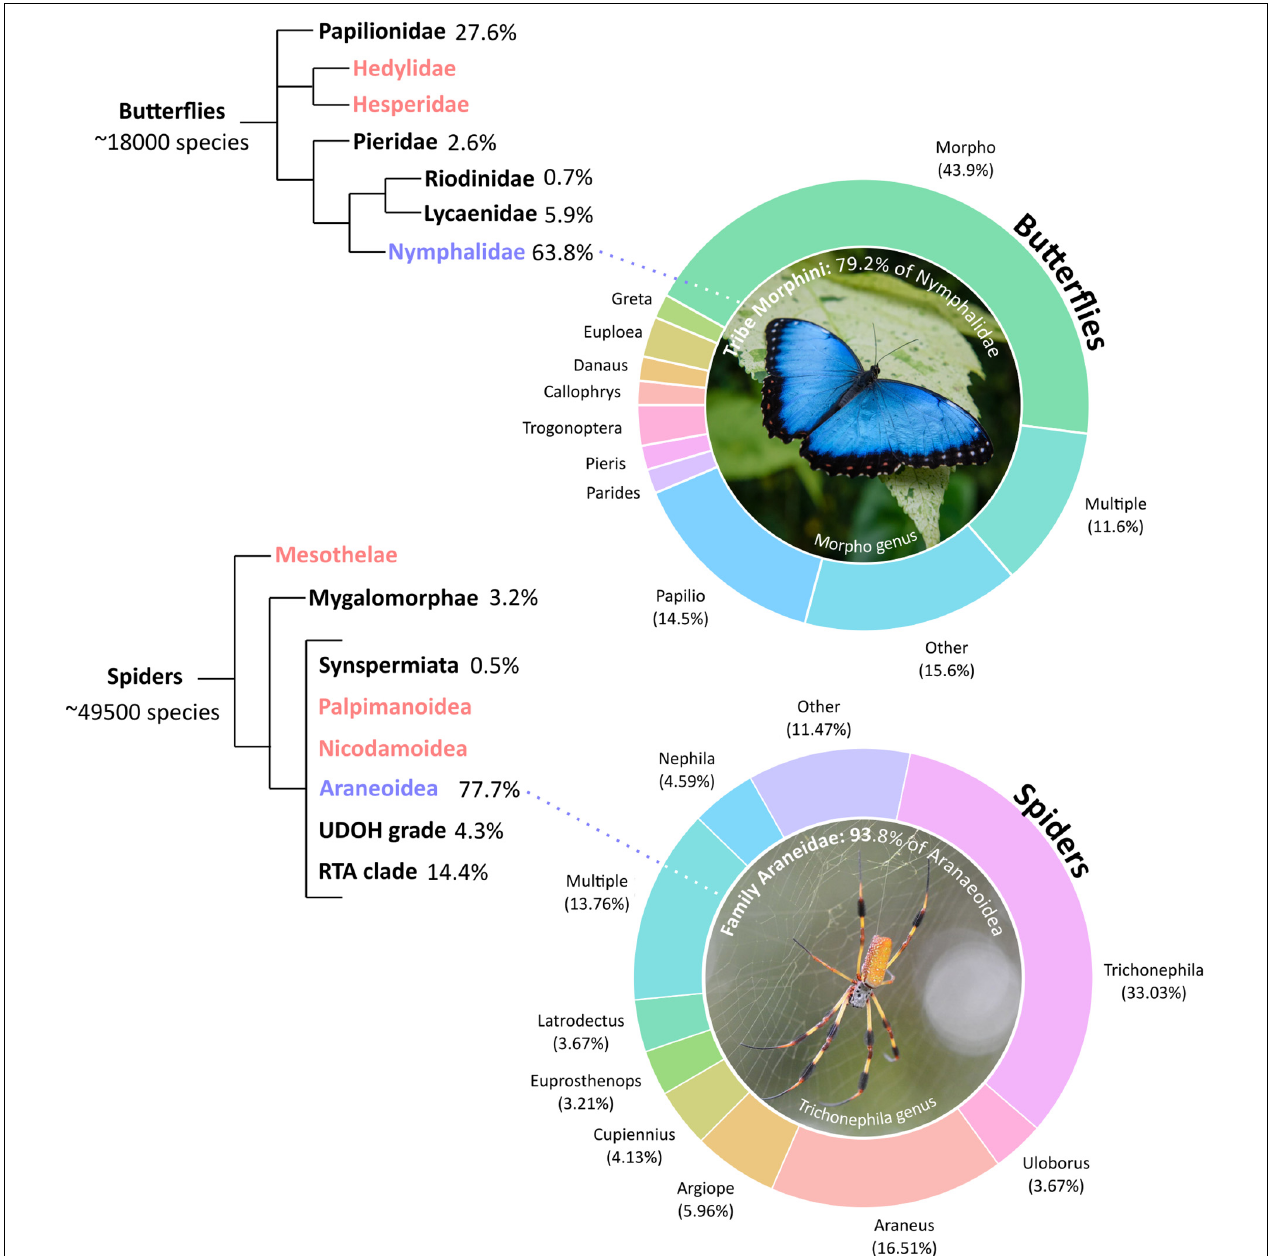
FIGURE 1 | Taxonomic distribution of butterfly and spider bioinspiration/biomimetic research. Donut charts represent the distribution of genera for each taxonomic group, based on 173 papers on butterflies and 218 papers on spiders. Percentages are the percentage of the identified papers focusing on each taxon. “Multiple” indicates research including multiple focal species, while “Other” indicates the sum of genera with less than 3% representation. Tree diagrams show the representation of major phylogenetic groups within butterflies (Rhopalocera) and spiders (Araneae). Red indicates groups with no representation, and blue represents the group with the most representation. Most species within both animal groups belong to a select few genera, and are largely represented by two phylogenetic groups only. Original photos by Michal Mrozek (butterfly) and Tom Earnhardt